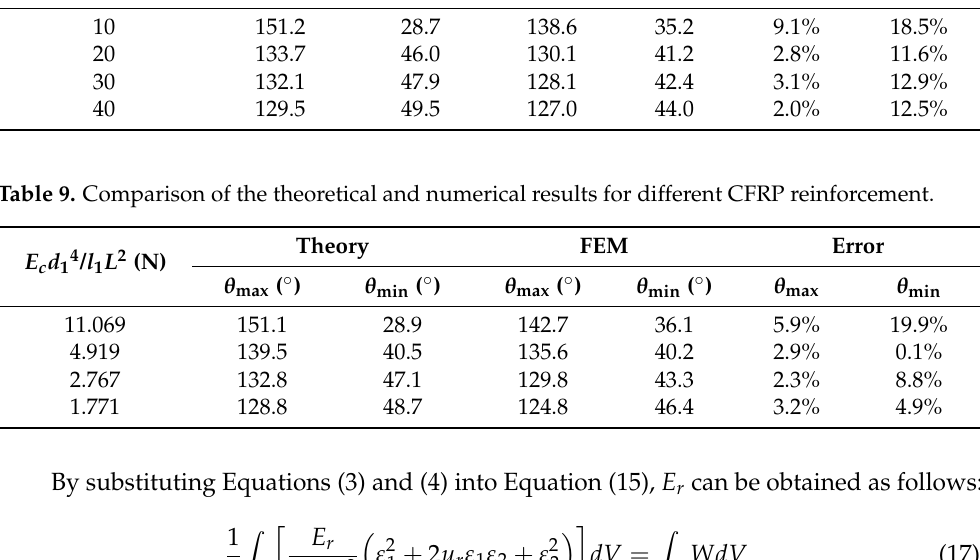
Table 8. Comparison of the theoretical and numerical results for different hardness. Hardness (HS)